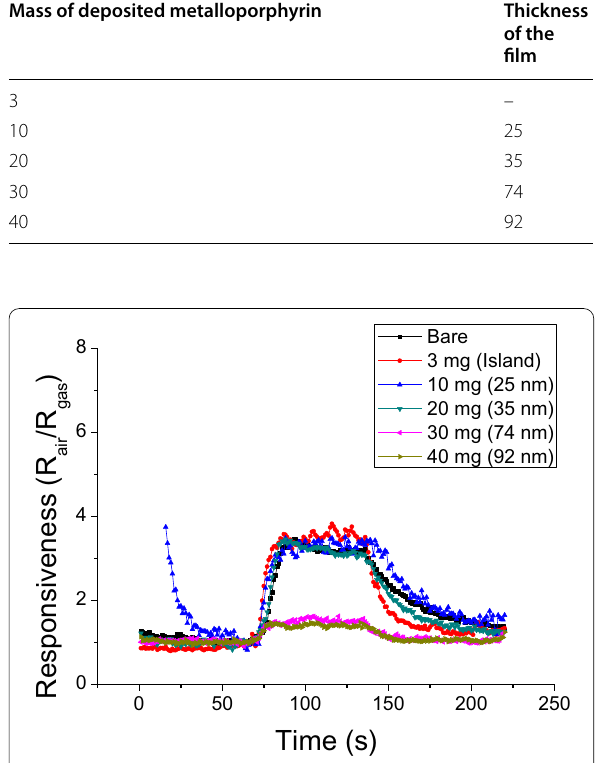
Fig. 2 Transient response characteristics of the fabricated